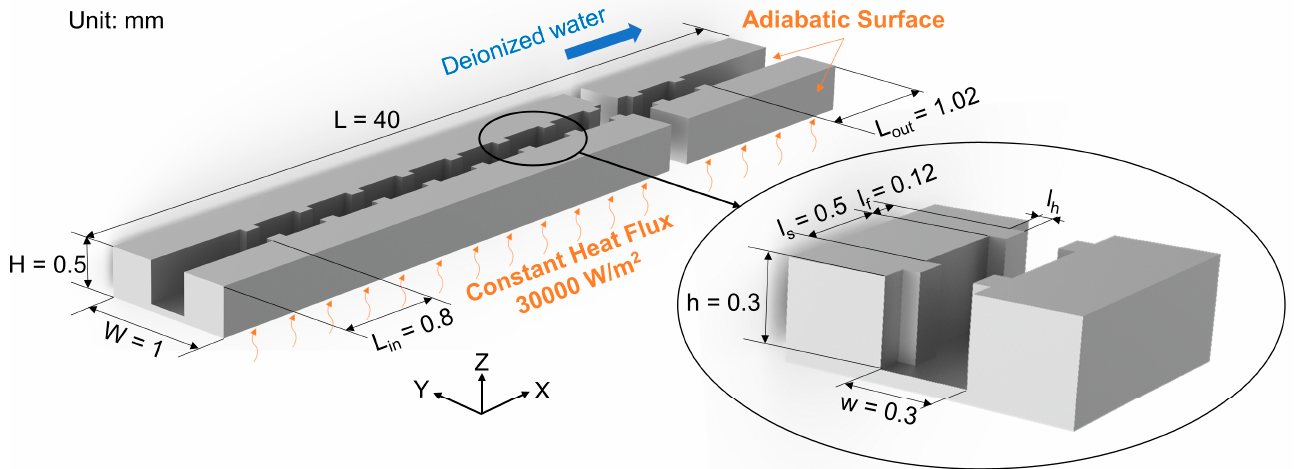
Figure 1. Schematic of the microchannels. All the surfaces are adiabatic except the solid–liquid contact surface and heating surface at the bottom of the solid. The top surface of the fluid domain is closed and does not allow any mass or heat transfer. A constant heat flux density of 30000 W/m 2 is applied on the bottom surface of the solid. The structural parameters (mm) are H = 0.5, L = 40, W = 1, L in = 0.8, L out = 1.02, h = 0.3, w = 0.3, l s = 0.5, and l f = 0.12.